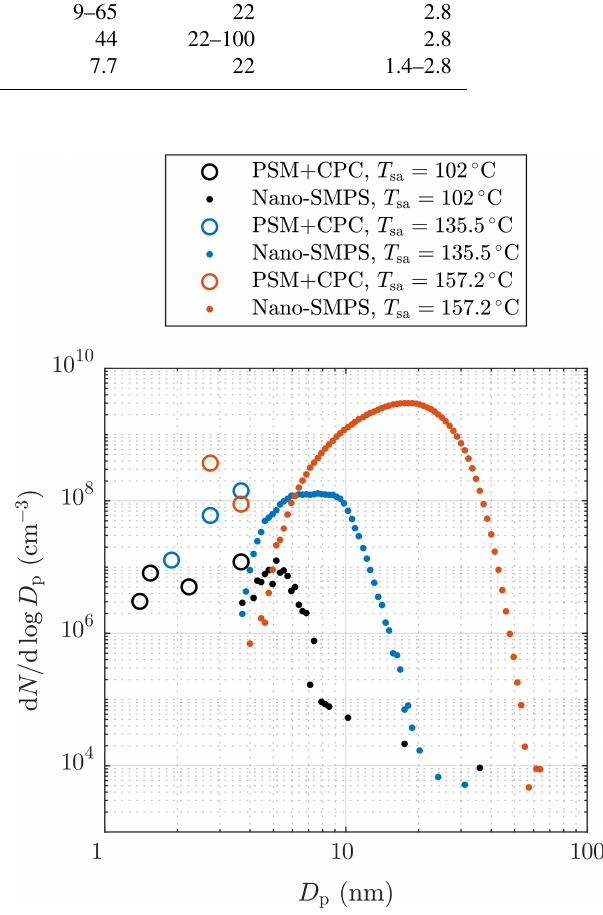
Figure 4. Examples of particle size distributions after the ejector diluter, measured with different H 2 SO 4 evaporator temperatures in measurement set 1. The data are corrected with the dilution ratio of the bridge diluter and with the diffusional losses in the sampling lines after the ejector diluter. The concentrations are multiplied by the total dilution ratio of the sampling system. See the Supplement for error